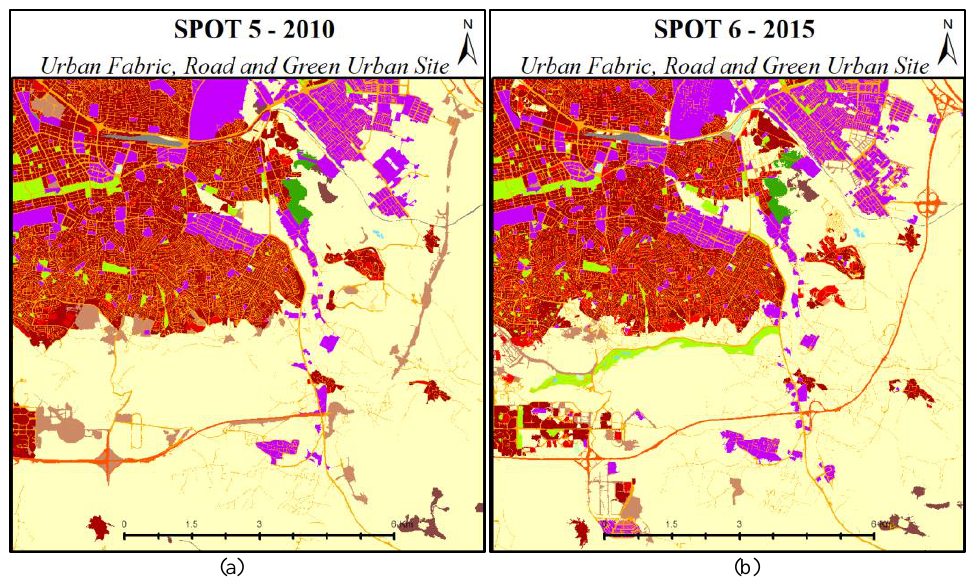
Figure 7. Changes in land use/cover for roads and green urban sites (a) 2010 SPOT 5, (b) 2015 SPOT